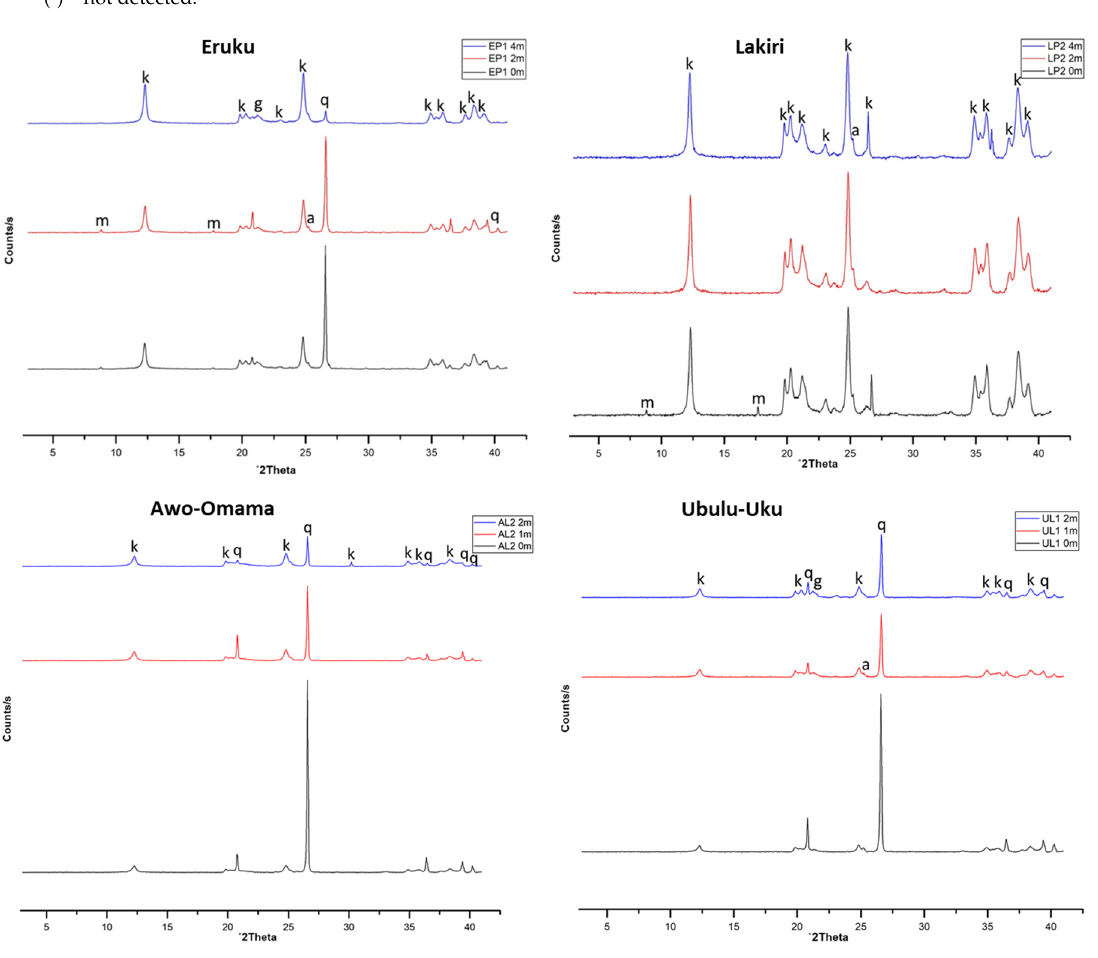
Figure 4. X-ray diffractograms of the profiles of the studied kaolin deposits with the highest kaolinite contents showing kaolinite ( k ), quartz ( q ), muscovite ( m ), anatase ( a ), and goethite ( g ).